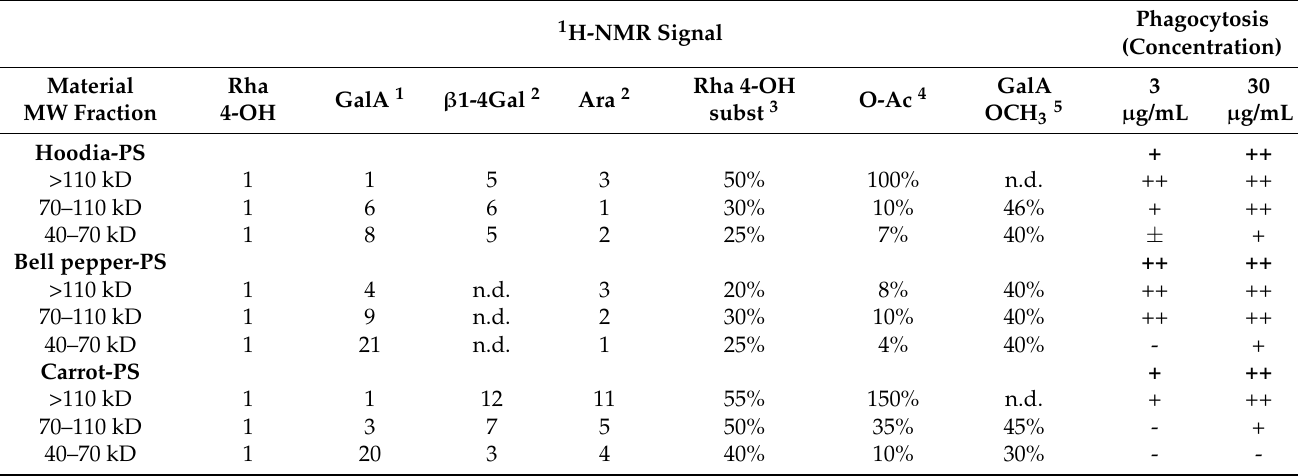
Table 1. Sugar composition relative to Rha signal based on 1 H-NMR data of mildly acidic size-separated subfractions of hoodia-PS, bell pepper-PS and carrot-PS, and potency to stimulate in vitro phagocytosis. 1 H-NMR Signal Phagocytosis